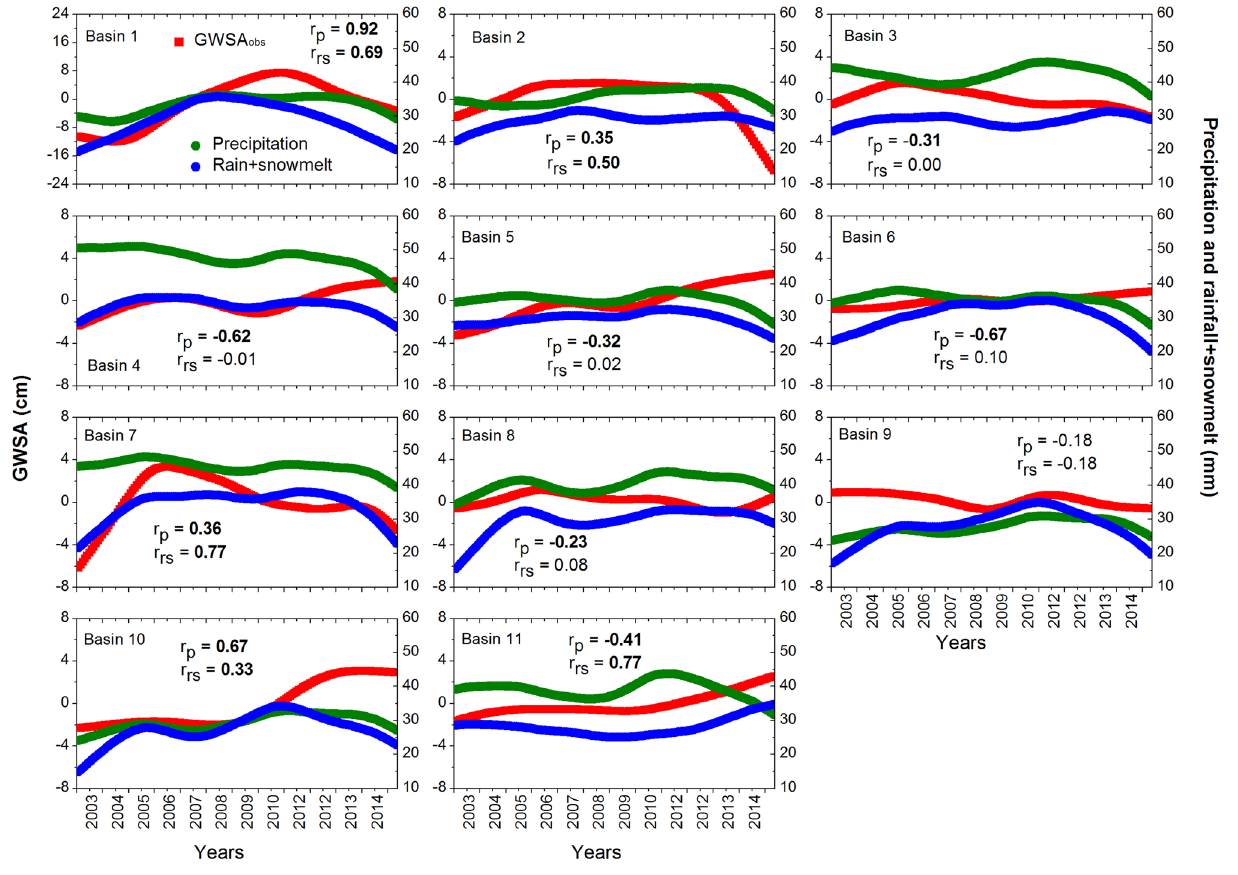
Figure 8. Basin-wide time series of HP filter data for in situ GWSA (OBS, red squares), precipitation data (green circles), and rain- fall + snowmelt data (blue circles). Pearson’s correlation coefficient ( r ) values are provided in the inset and statistically significant ( p value < 0 . 01) values are shown in bold. r p and r rs indicate the correlation between GWSA and precipitation and between GWSA and rainfall + snowmelt,